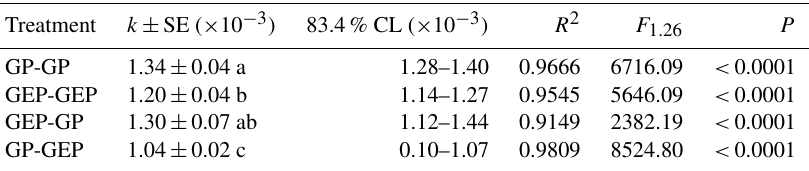
Table 2. Litter decay rate ( k , g10g − 1 day − 1 ) in different incubation environments. GP-GP, mixed litter was collected from grazing paddocks (GP) and incubated in GP; GEP-GEP, mixed litter was collected from grazing exclusion paddocks (GEP) and incubated in GEP; GEP-GP, mixed litter was collected from GEP and incubated in GP; GP-GEP, mixed litter was collected from GP and incubated in GEP. k values followed by different letters are significantly different (non-overlap of 83.4% CL). R 2 , F and P are estimated from the negative exponential model of Swift et al.